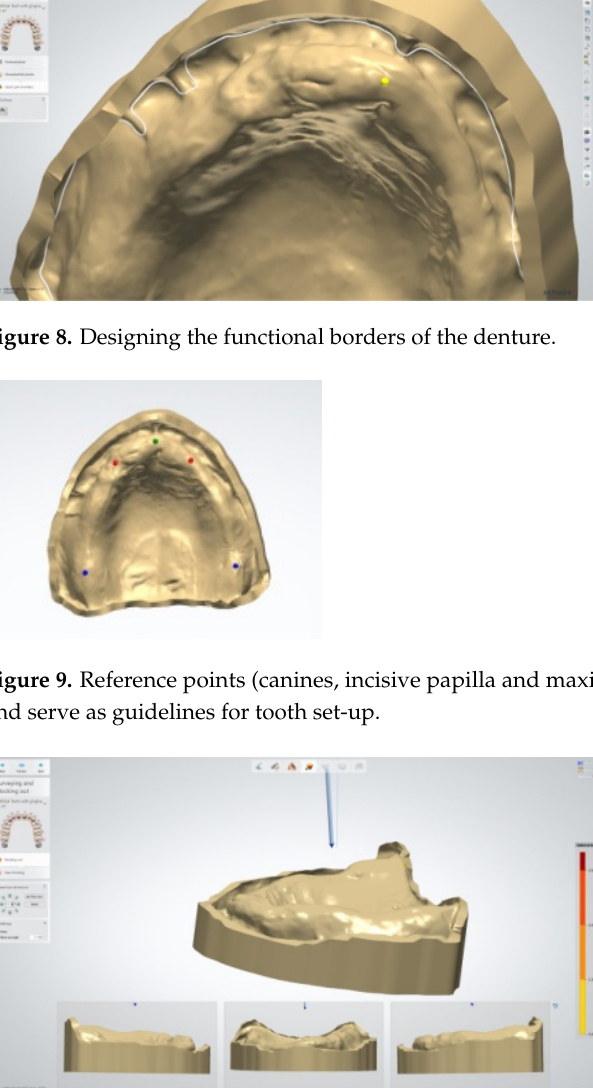
Figure 10. Ideal denture’s path of insertion.